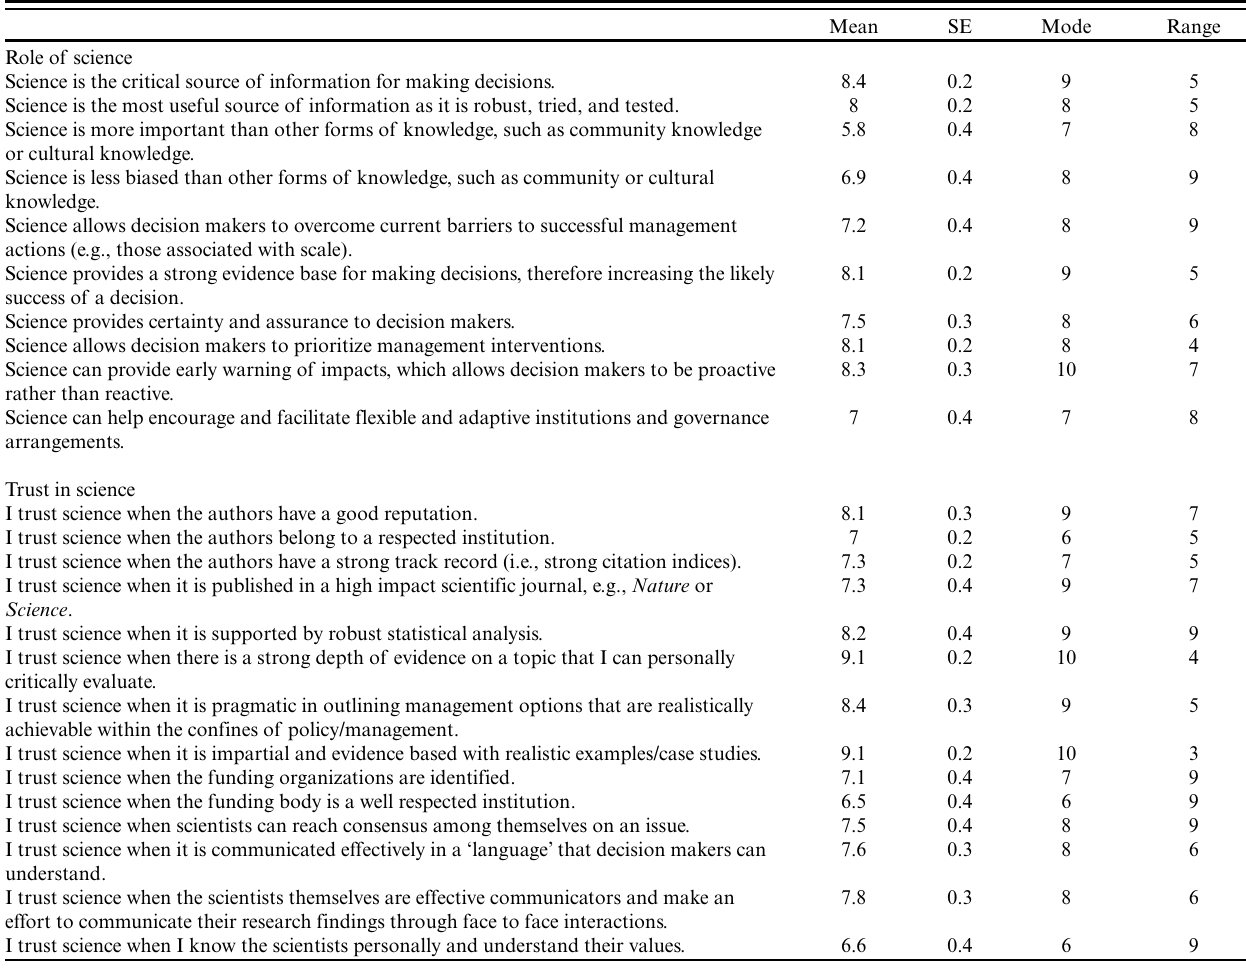
Mean SE Mode Range